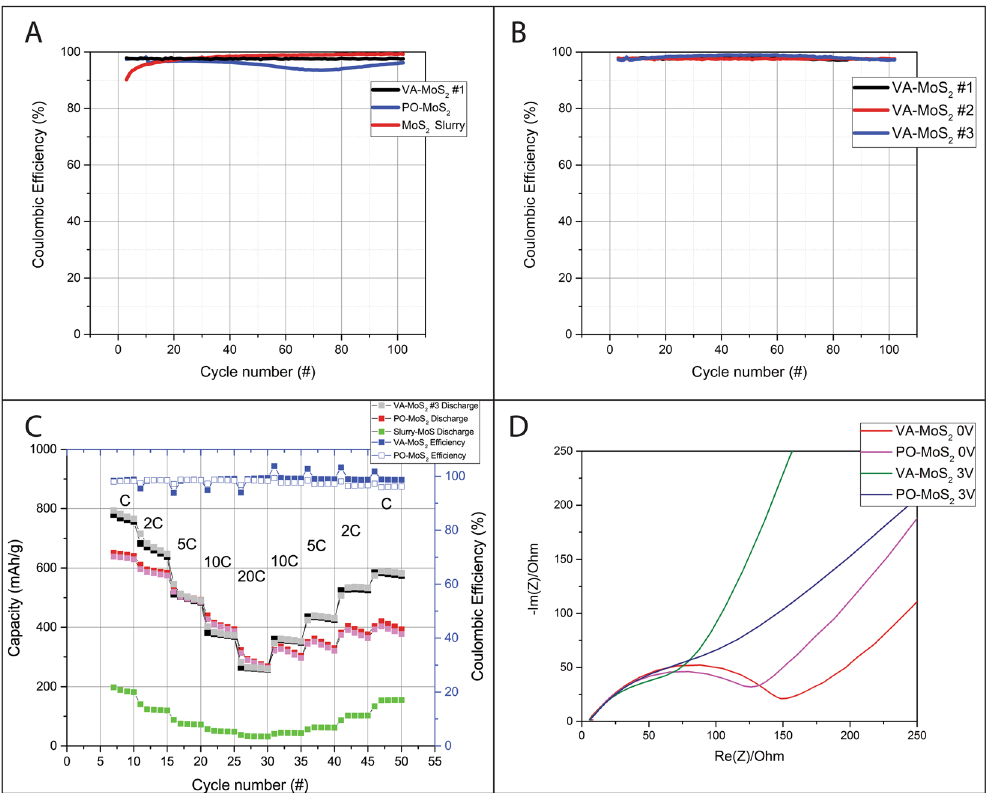
Figure 8. Coulombic efficiency at C rate of VA-MoS 2 #1 (black), PO-MoS 2 (red) and slurry (blue) ( A ); Coulombic efficiency at C rate of VA-MoS 2 #1 (black), VA-MoS 2 #2 (red) and VA-MoS 2 #3 (blue) ( B ); C-rate of VA-MoS 2 #1 (black), PO-MoS 2 (red) and slurry (green) with the corresponding coulombic efficiency for VA- MoS